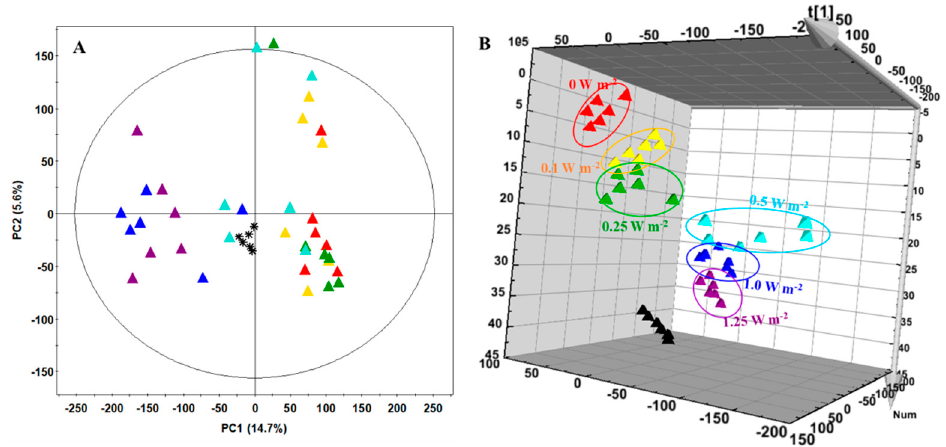
Figure 6. Principal component analysis (PCA) ( A ) and partial least squares discrimination analysis (PLS-DA) ( B ) score plots analyzed by ultra high performance liquid chromatography-linear ion trap-Orbitrap mass spectrometer (UPLC-LTQ-Orbitrap-MS) of C. denticulatum subjected to different energy levels of UV-B radiation for 4 days. (cid:78) , 0 W m − 2 ; (cid:78) , 0.1 W m − 2 ; (cid:78) , 0.25 W m − 2 ; (cid:78) , 0.5 W m − 2